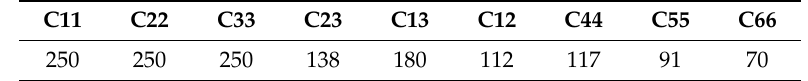
Table 4. Elastic constants (in GPA) for austenitic stainless steel extracted from the CIVA database.